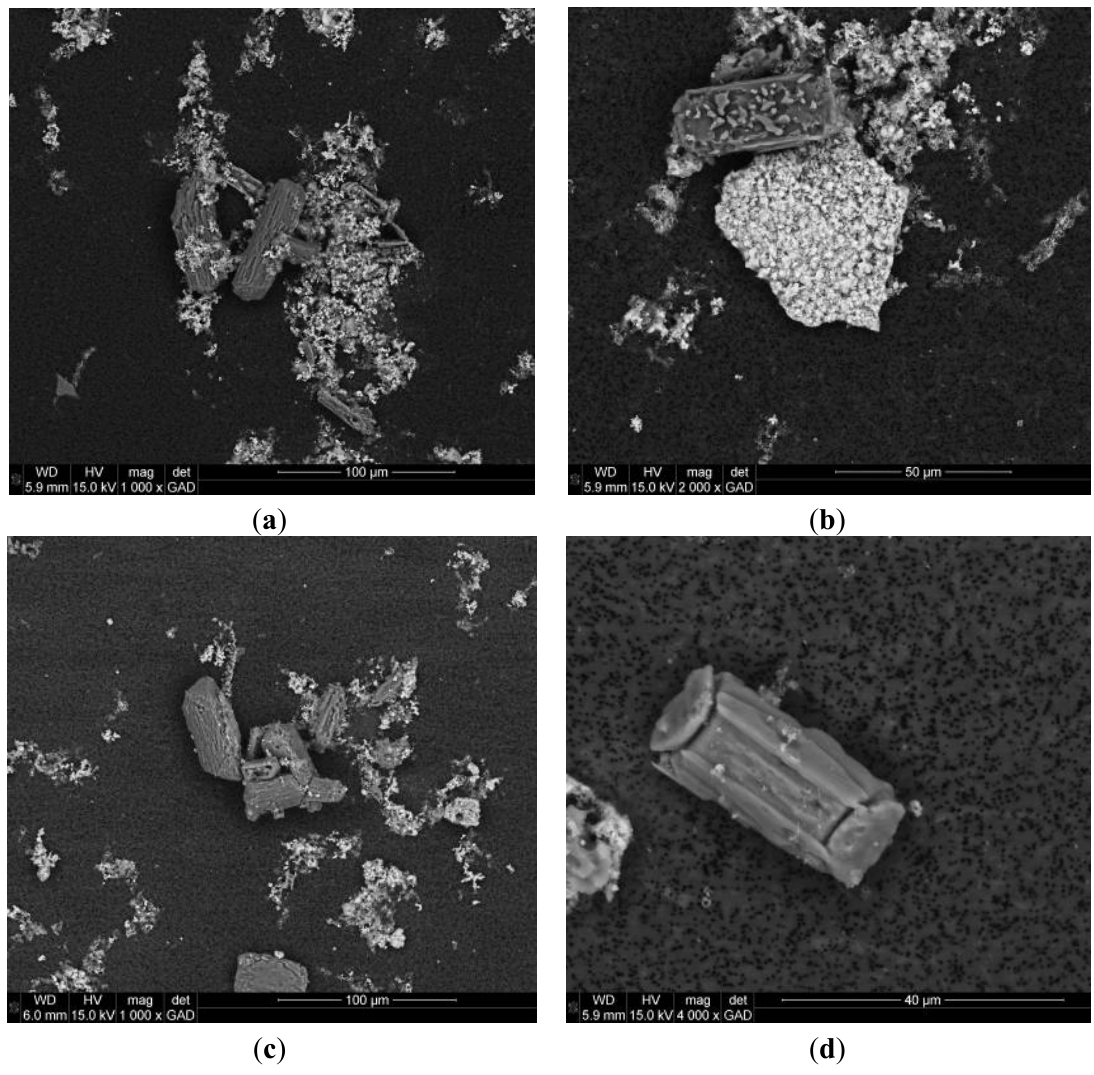
Figure 3. Scanning Electron Microscopy images of crystals in the